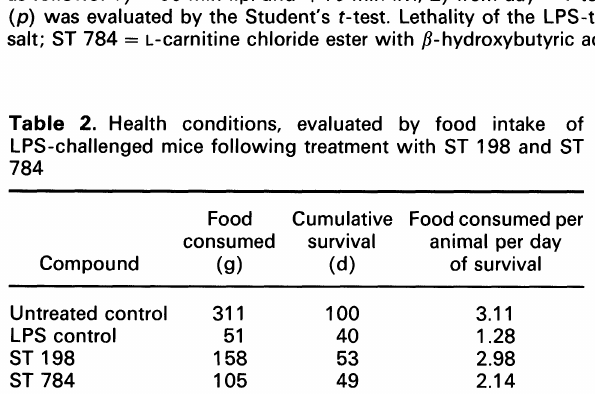
Treatments were performed by injecting LPS 30 mg/kg i.p. at time zero and administering the compounds, at the dose indicated, as follows: 1) -60 min i.p. and + 10 min i.v., 2) from day